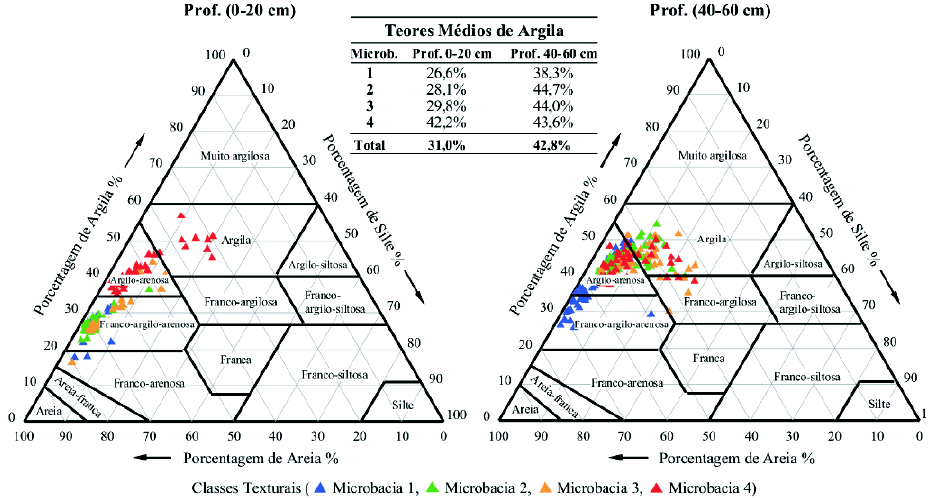
Figura 3. Classes texturais das microbacias em duas profundidades.